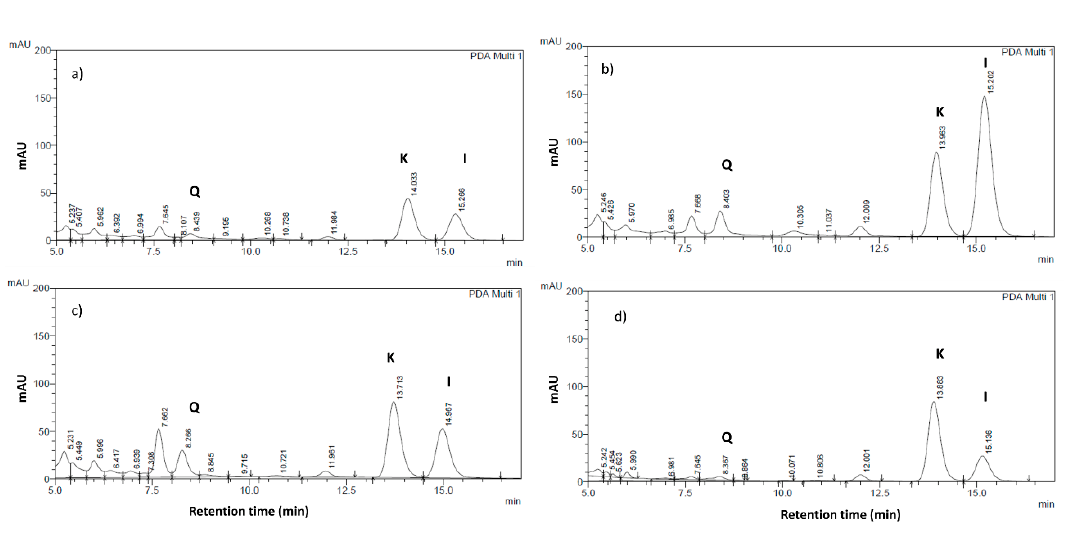
Fig. 1: Chromatograms obtained by reverse phase HPLC of the fl avonoid profi le identifi ed in four nopal cultivars. a) O. fi cus-indica cv. Atlixco; b) O. fi cus- indica cv. Milpa Alta; c) O. fi cus-indica cv. Jade; d) N. cochellinifera cv. Texas. Abbreviations: Q = quercetin, K = kaempferol, I = isorhamnetin.